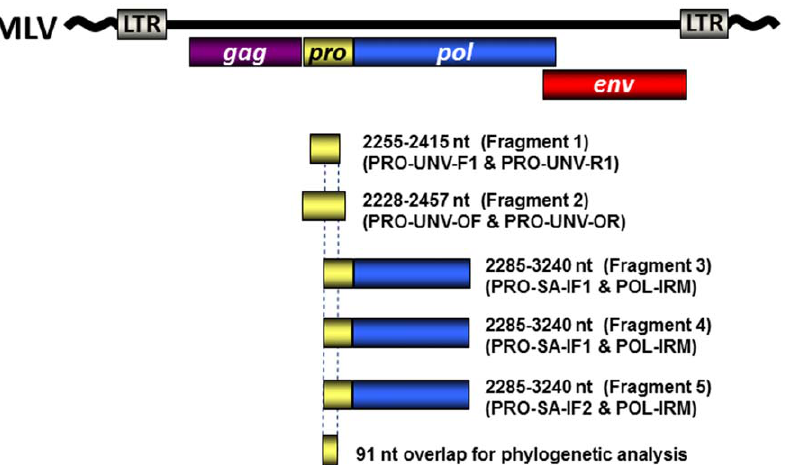
Figure 1. Schematic showing locations and sizes of endogenous retrovirus sequences detected in the live, attenuated Japanese encephalitis virus (JEV) vaccine (SA-14-14-2) and in hamster cell lines. Primer positions are relative to an alignment of prototypical murine leukemia viruses (MLV). Primer names and PCR fragments obtained are provided in parentheses. LTR, long terminal repeat; gag , group specific antigen; pro , protease; pol , polymerase; env , envelope. Also shown is the 91-bp overlap region used for phylogenetic analysis of all PCR-amplified fragements. Quantitative PCR with the Taqman primers Pro-UNV-F1 and Pro-UNV-R1 were used to originally detect gammaretroviruses in the JEV vaccine and hamster cell line DNA (fragment 1, 161-bp). Four additional primer sets were used to amplify larger gammaretrovirus sequences for further genetic characterization (Fragments 2–5). Nested PCR was used for obtaining fragments 3–5 and all amplified sequences were about 950-bp in length. Only the inner most primer name combinations are shown. The primers PRO-UNV-OF 5 9 TAGGGAGGTC AGGGTCAGGAGC3 9 and PRO-UNV- OR 5 9 GGAAAGAGTGRGTGACCT TACCGGT3 9 were used to amplify a second fragment (283-bp). The primary PCR amplification for fragment 3 used the primers PRO-UNV-F1 and XPOLIR 5 9 AAGTGGCGG CCAGCAGTAAGTCAT3 9 , while the outer primers for fragments 4 and 5 were PRO-UNV-OF and XPOLIR. The internal primers for fragments 3 and 4 were PRO-SA-IF1 5 9 GAGCAACC AGTCACCTTCCTA3 9 and POL-IRM 5 9 TCTGGGTGCTGGATCCGGAA3 9 , while the internal primers for fragment 5 were PRO-UNV-IF2 5 9 GGGCGCCCRGTCACCTTCCTG3 9 and